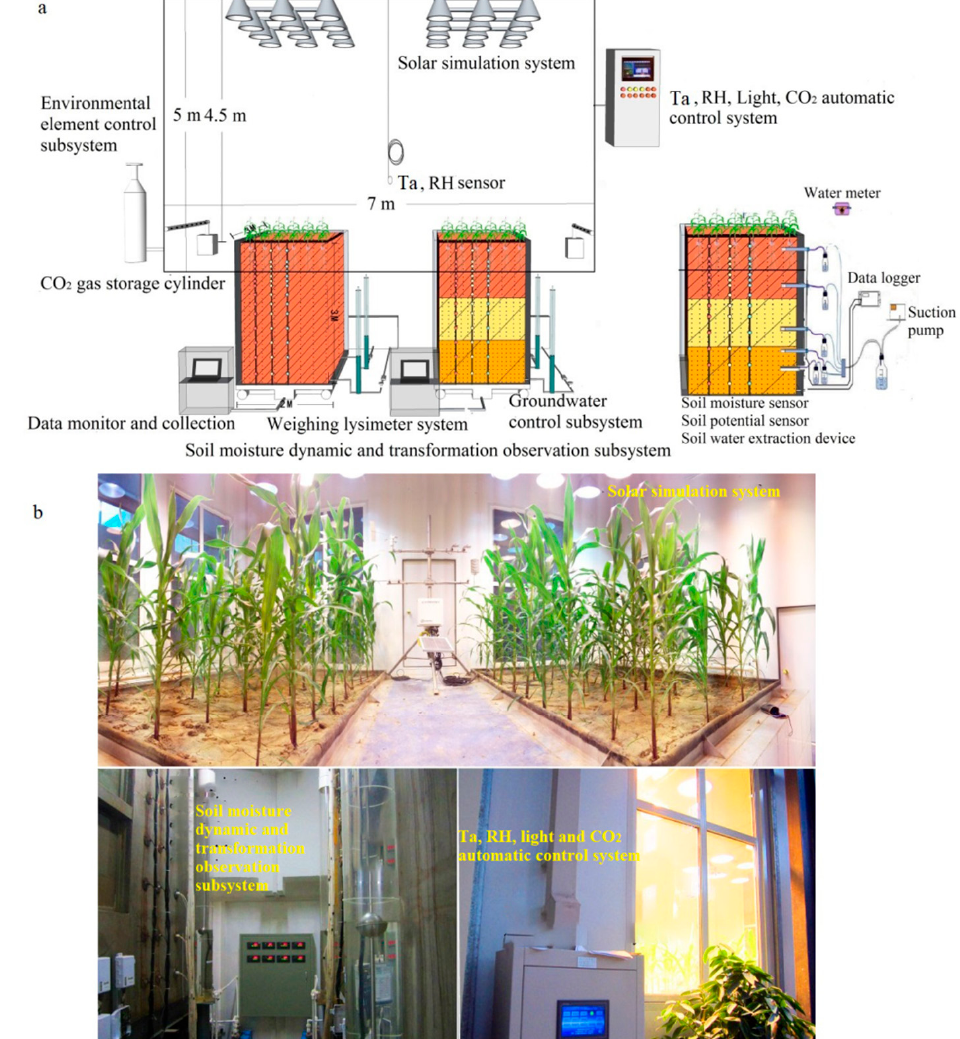
Figure 1. Schematic diagram ( a ) and photographs ( b ) of the water transformation dynamical processes experimental device (WTDPED). Ta and RH represent air temperature and relative humidity, respectively.